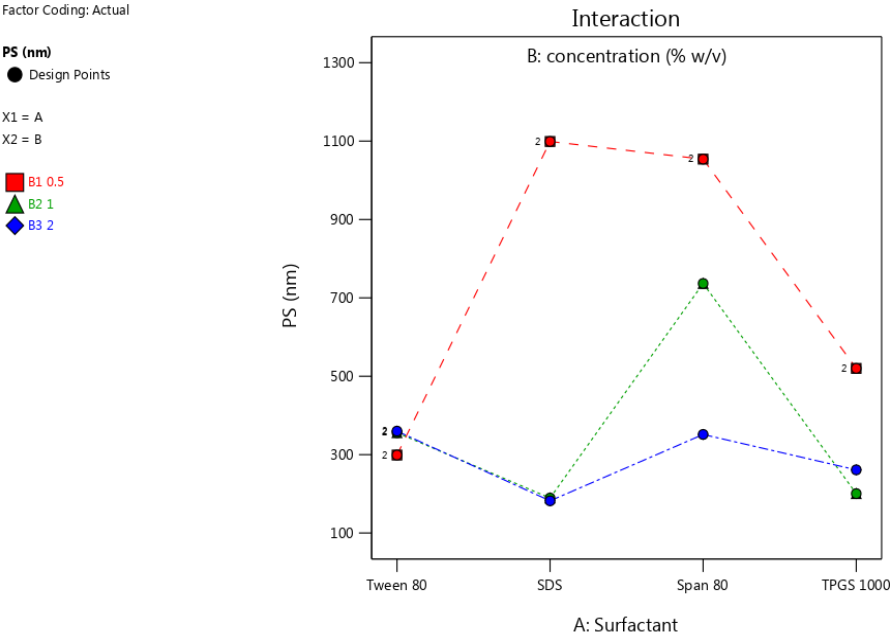
Figure 5. PS of nano co-crystals using different surfactants at concentrations of 0.5% w/v (red), 1% w/v (green) and 2% w/v (blue).